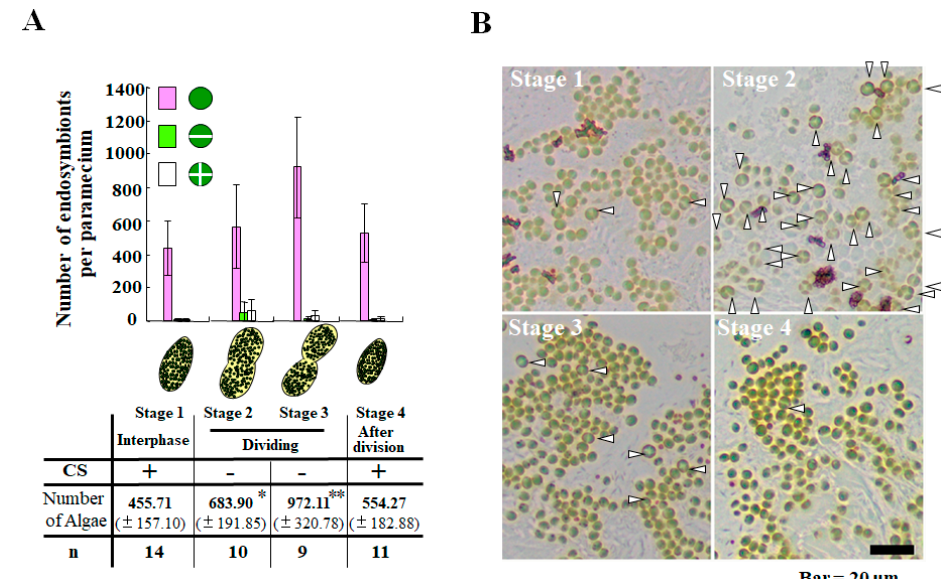
Figure 3. Cytoplasmic streaming of P. bursaria and the number of endosymbiotic algae in each host cell through the host cell cycle. ( A ) The bar graph shows the numbers of endosymbiotic algae in respective host cells (average ± S.D.) at respective phases of the host cell cycle (stages 1–4). The endosymbionts are classified into a unicellular cell (purple), 2 (green), and 4 autospores (white) in this panel. The table presents whether cytoplasmic streaming of P. bursaria occurs (+) or not ( − ), and the total number of endosymbiotic algae in P. bursaria . Here, * and ** respectively denote significant differences with t -test, * p < 0.005 and ** p < 0.001 vs. the number of endosymbionts in a host cell at the interphase. Panel A was referred from the literature [15]. ( B ) Microphotographs at each phase of host cell cycle: arrowheads indicate endosymbiotic algae at 2 and 4 autospores. Scale bar, 20 µm. The panel presents unpublished data from a study of the literature [15].